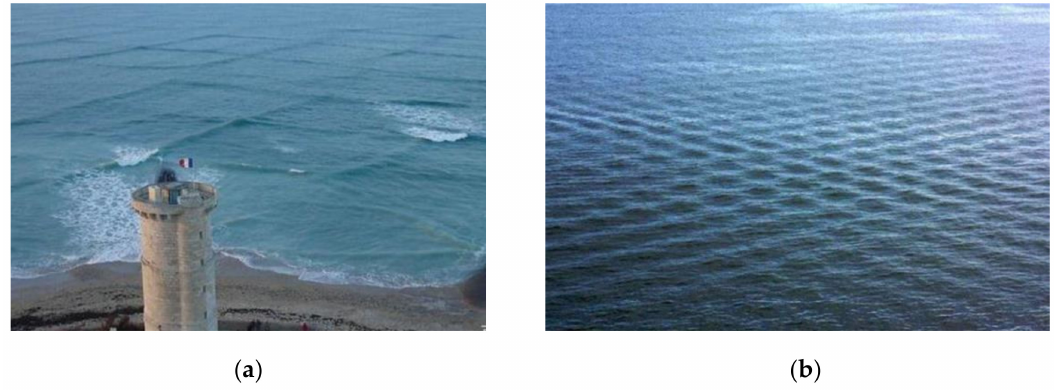
Figure 1. Phenomenon of cross sea wave: ( a ) swell wave; ( b ) wind